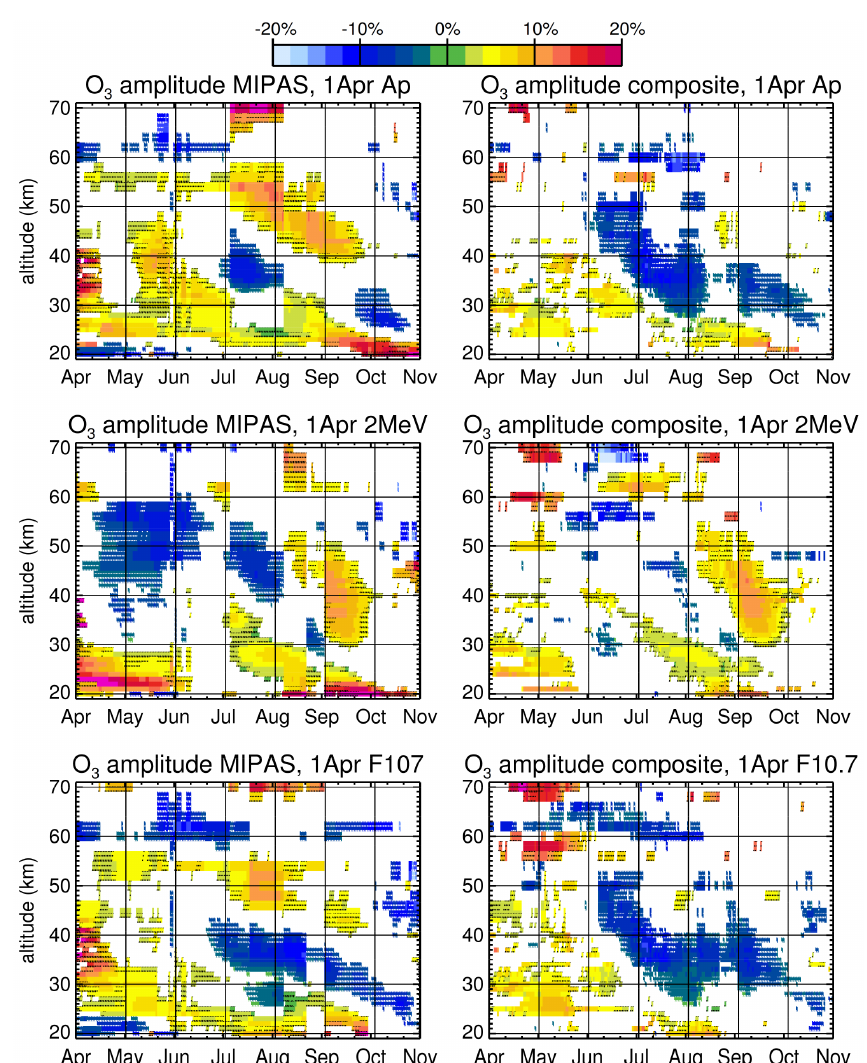
Figure 3. O 3 amplitude (see Sect. 3.1.1 for definition) inside the Antarctic polar vortex between years of high index values and years of low index values, namely Ap index (upper row), ≥ 2MeV electron flux (middle) as well as F10.7cm solar radio flux (lowermost row) centred around 1 April, derived from MIPAS (left column) and composite (MIPAS + SMR + SABER, right column) observations from 2002 to 2011. Shown are only values above the significance level of 95%. Additionally, regions between the significance level of 95 and 99% are shaded in black or white, according to a Student’s t